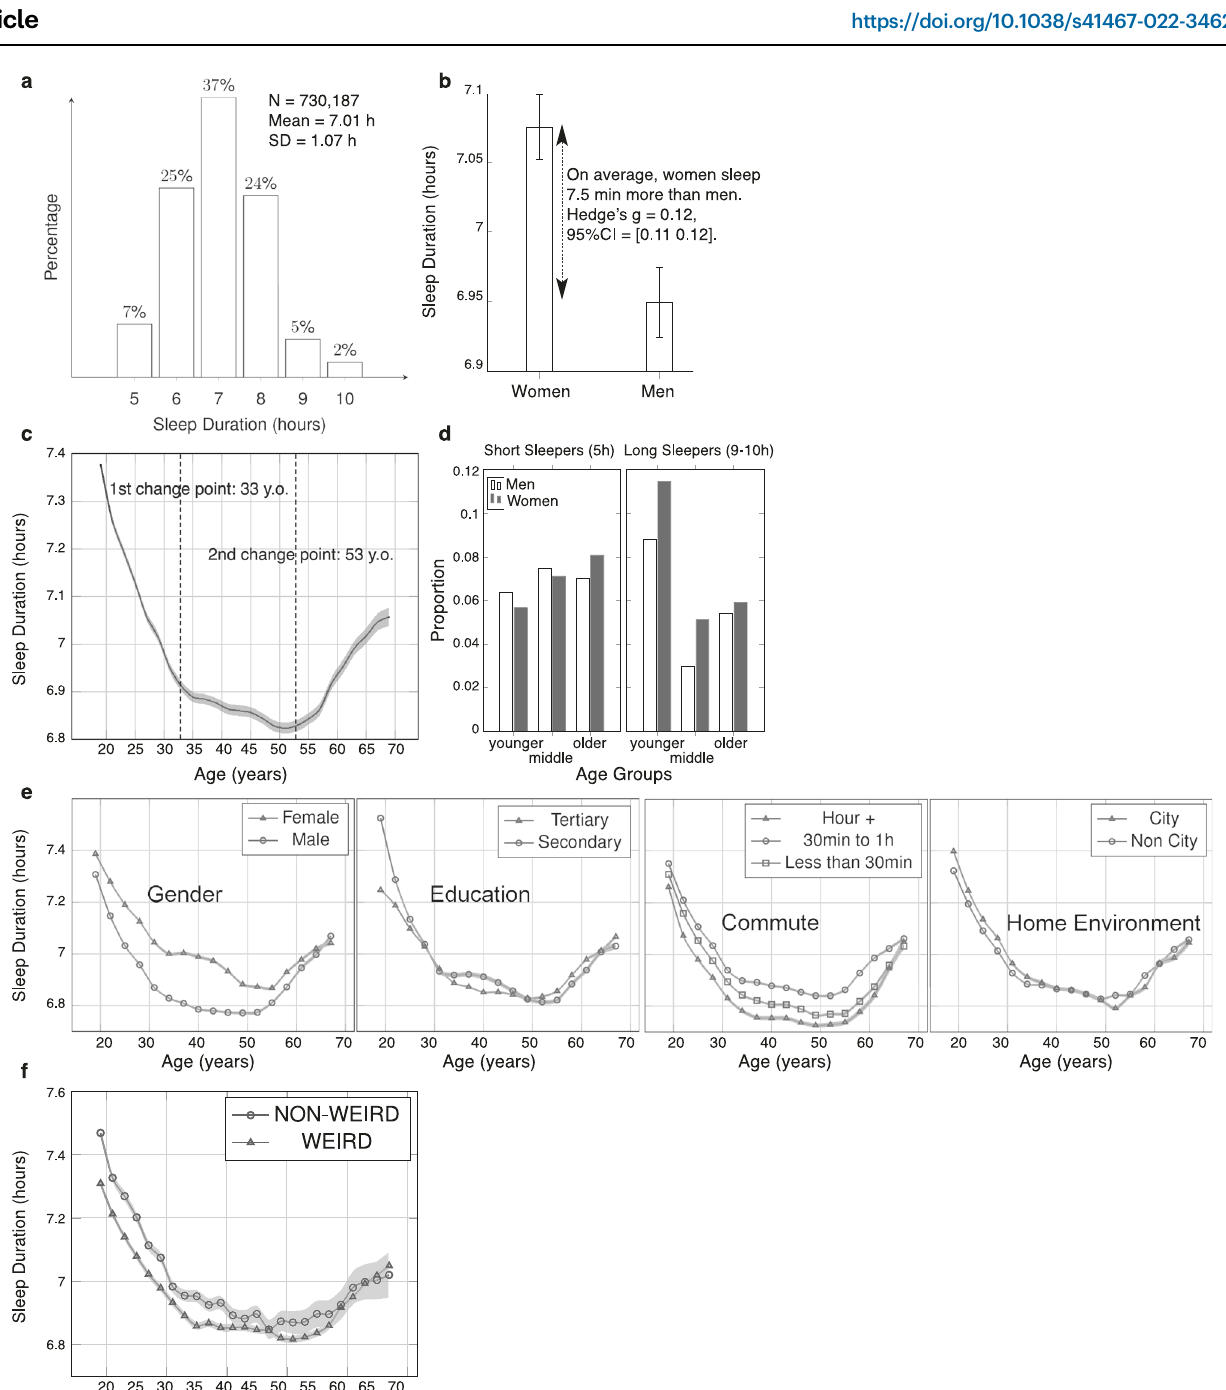
(204,017secondary,526,170tertiary),commuteduration(291,822lessthan30min, 254,36230minto1h,183,764hplus)andhomeenvironment(222097city,508090 non city). f Reported sleep duration across age for WEIRD ( n =526,136) and non- WEIRD ( n =204,051) populations. WEIRD stands for Western, Educated, Indus- trialized, Rich and Democratic 26 . Data points correspond to the average reported sleep duration within 3-year windows. Error bars correspond to 95% con fi dence